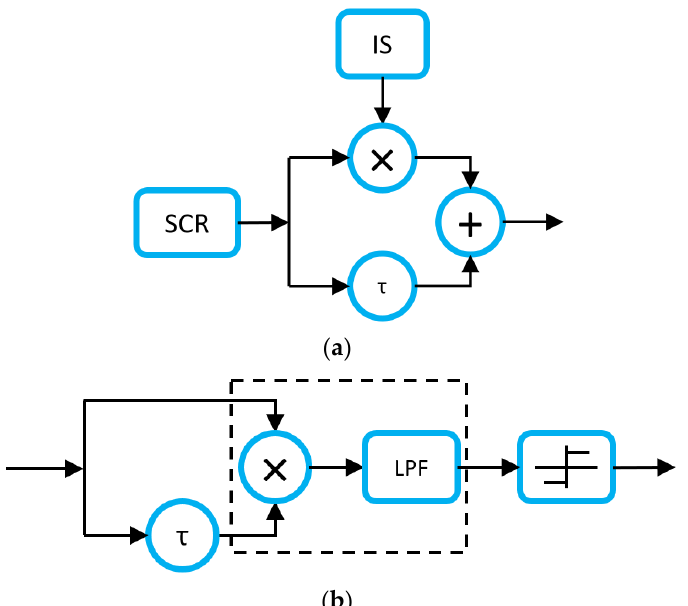
Figure 3. DC 2 scheme: ( a ) transmitter: SCR—source of chaotic radio pulses, IS—information se- quence, τ —time delay; ( b ) receiver: τ —time delay; LPF—low pass filter.